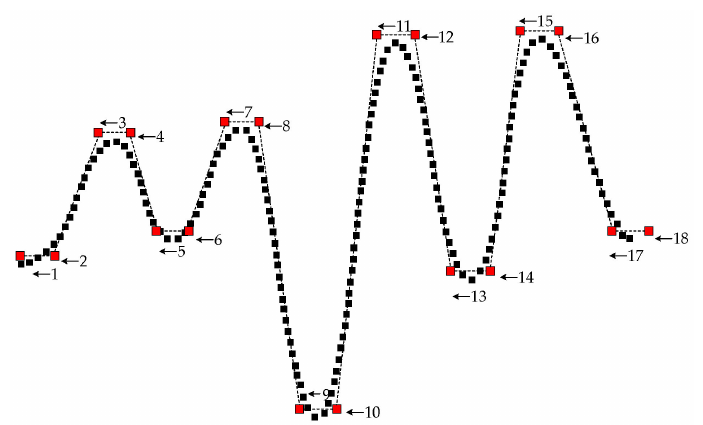
Figure 16. Schematic diagram of B-spline equally spaced sampling smoothing